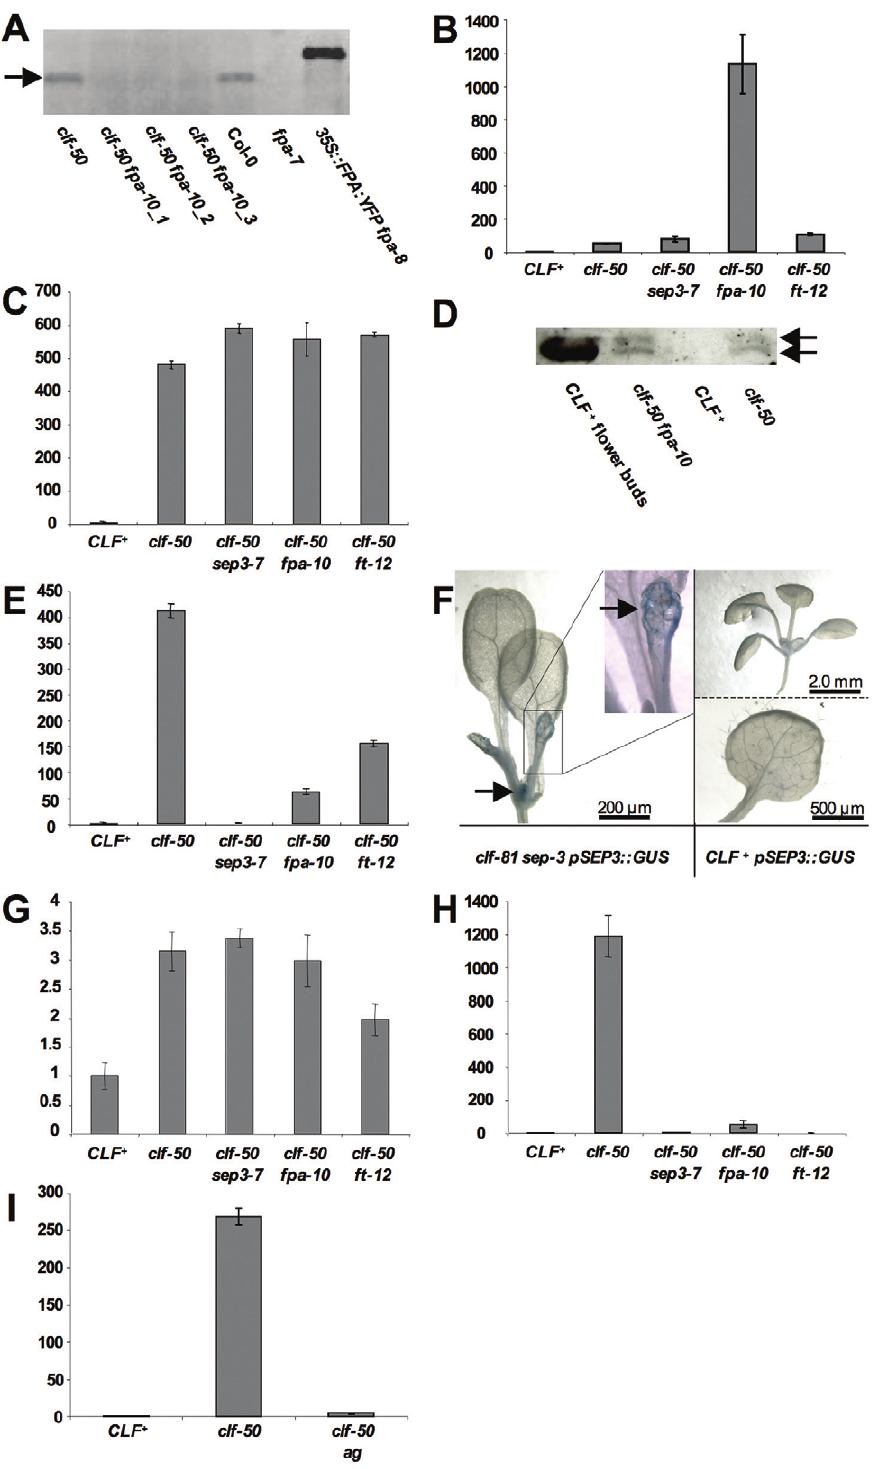
Figure 3. Gene expression in suppressor mutants. ( A ) Western blot analysis of FPA protein levels. Three independent clf-50 fpa-10 samples were processed. Note that no protein is detected in the null fpa-7 control, whereas in extracts from a 35S::FPA-YPA transgenic line a larger product corresponding to the FPA-YFP fusion protein is detected, confirming the specificity of the antibody for FPA. No FPA protein is detectable in fpa-10 extracts, indicating that fpa-10 is likely a null allele. ( B ) Real time PCR analysis of FLC expression. ( C ) Real time PCR analysis of AG expression, showing high AG expression in suppressor mutants. ( D ) Western blot analysis of AG protein expression. The AG antibody detects two proteins of about 29 kDa that are specific for AG, the smaller band possibly representing a truncated product or spurious translation initiation event (Riechmann et al., 1999). AG protein is strongly detected in wild type flowers but not in leaves. Weak expression is found in clf-50 and clf-50 fpa-10 leaves. ( E ) Real time PCR analysis of SEP3 expression. ( F ) Histochemical staining of GUS reporter gene activity. SEP3::GUS is not expressed in wild type leaves but shows weak